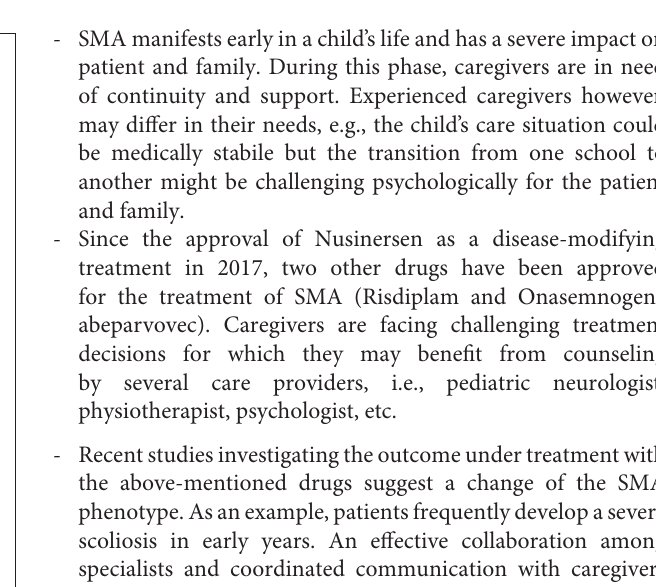
FIGURE 4 | Five steps of Case Management [modified after Wendt